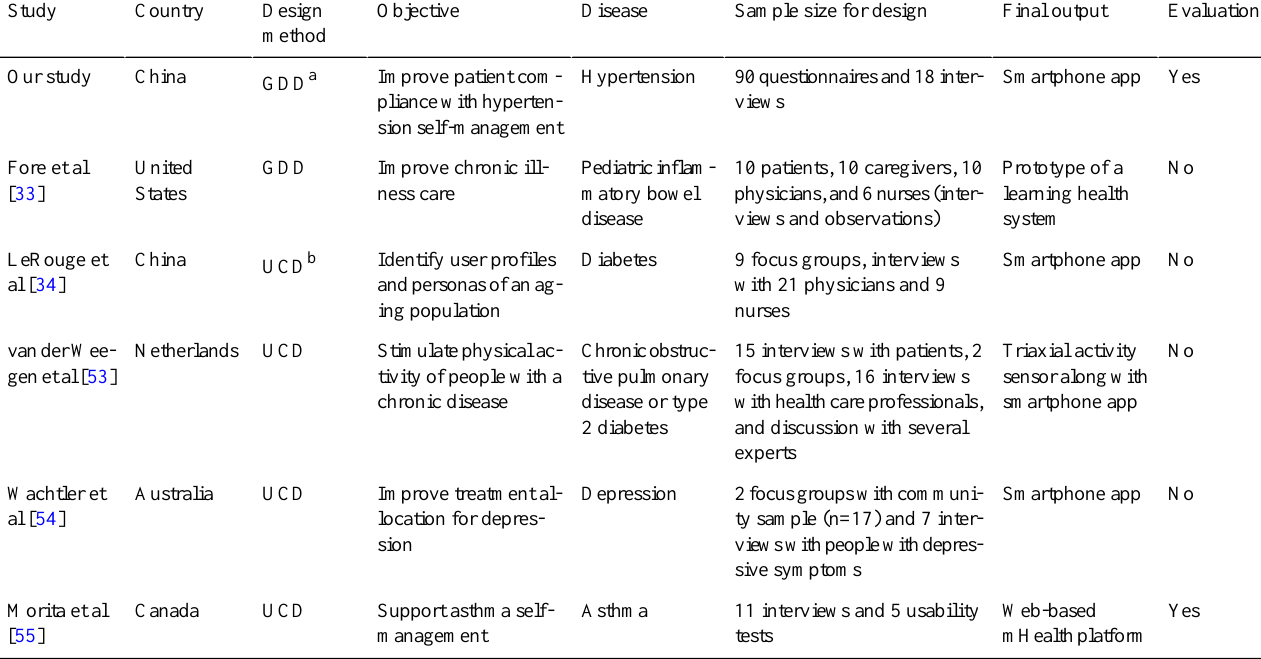
Table 9. Comparison of recent studies using theory-based design for disease